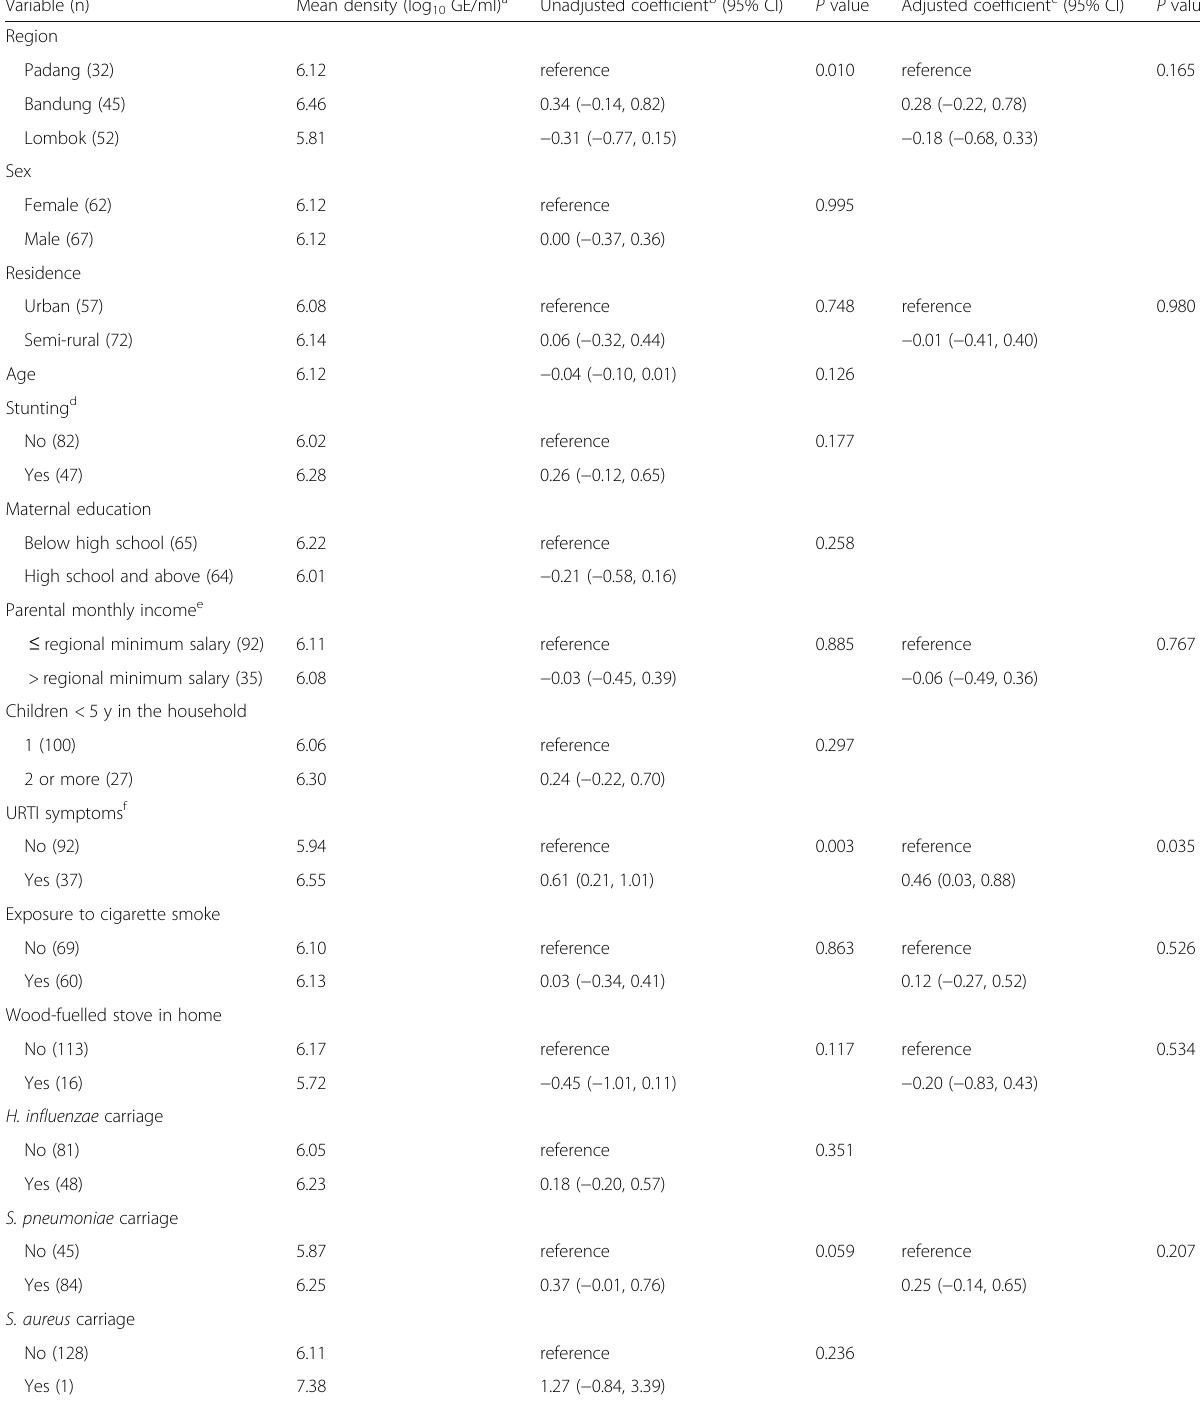
Table 5 Linear regression analysis of factors associated with M. catarrhalis density in children who are carriers ( n = 129) Variable